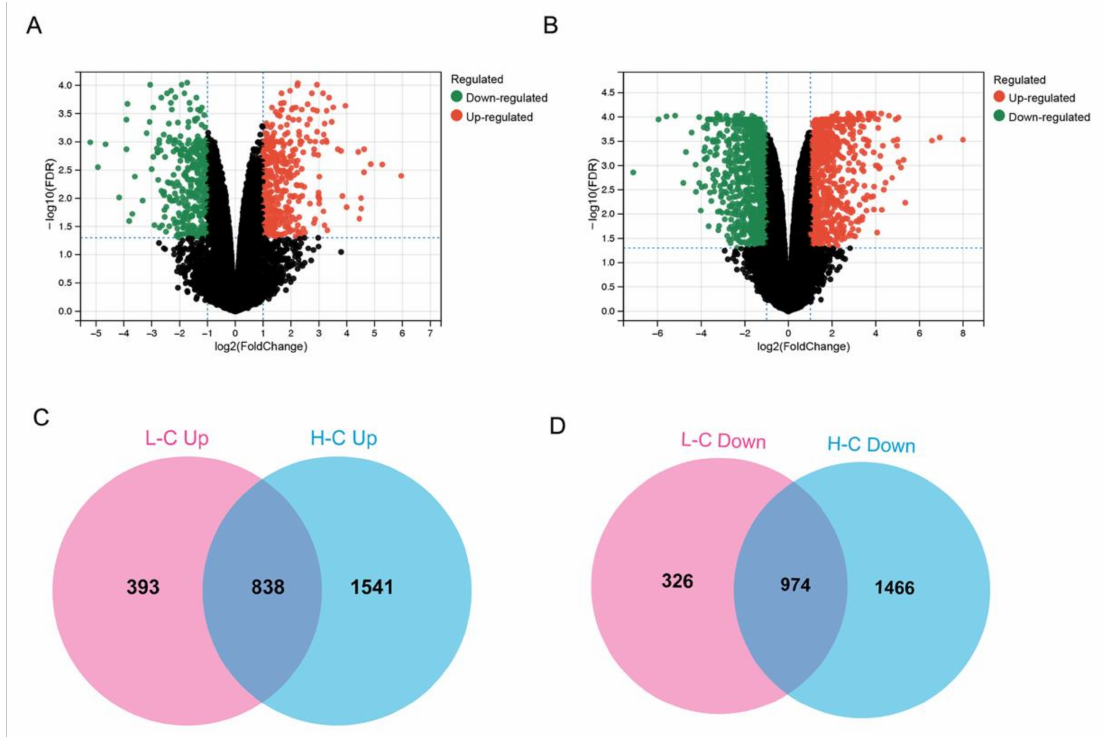
Figure 2. Gene expression alternation in PS-NP-treated BEAS-2B cells. ( A , B ): Volcano plots of significantly changed genes after PS-NP exposure at diverse concentrations ( A ) low-dose group vs control group and ( B ) high-dose group vs control group). ( C , D ): Up-regulated genes ( C ) and down-regulated genes ( D ) with consistent trend in two concentrations of PS-NP-treated groups. “L-C” denotes low-dose group vs control group, and “H-C” denotes high-dose group vs control